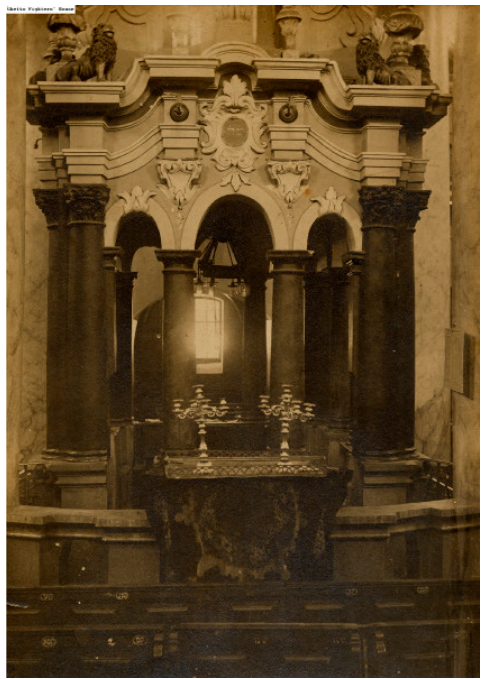
Figure 5. The front of the bimah with a cloth draped over the Torah reading table. Photo: Courtesy of Ghetto Fighters’ House, no. 31428.